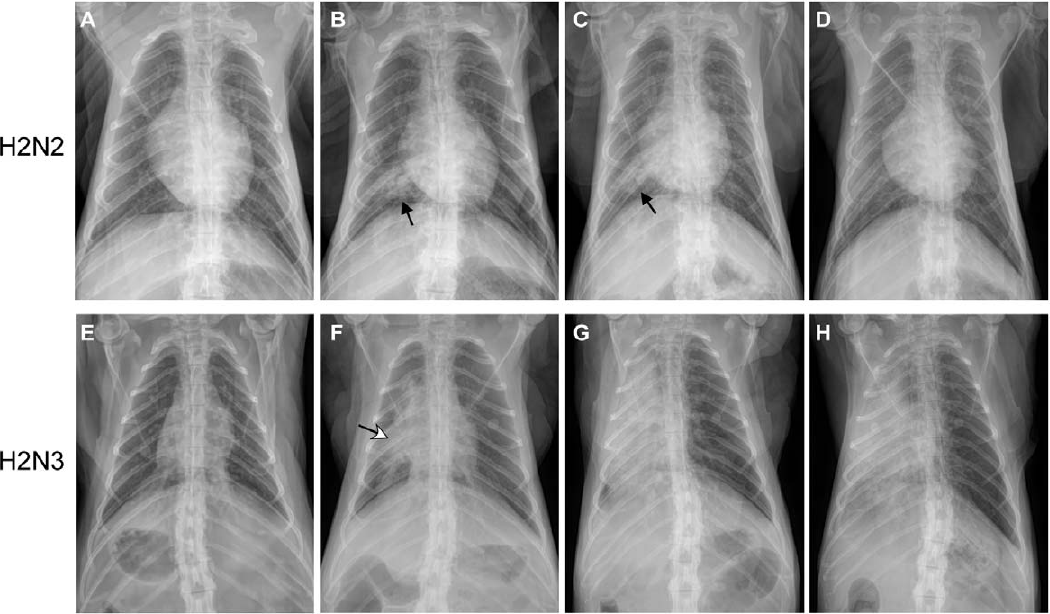
Figure 1. Radiographic imaging of disease progression. Time course ventrodorsal radiographs of representative macaques infected with either H2N2 or H2H3. Panels (A), (B), (C) and (D) represent time course radiographs from an individual animal at baseline, 3 dpi, 8 dpi, and 14 dpi infected with human H2N2 influenza virus. Focal interstitial radiographic changes (solid arrows) were noted on 3 dpi and 8 dpi but have resolved by 14 dpi. Panels (E), (F), (G) and (H) represent time course radiographs from an individual animal at baseline, 3 dpi, 8 dpi, and 14 dpi infected with swine H2N3 influenza virus. Focal interstitial changes with consolidation and partial effacement of the cardiac silhouette (open arrow) were noted. Radiographic changes are progressive on 8 dpi and 14 dpi with complete effacement of the cardiac silhouette and consolidation within the entire right hemi-thorax. Radiographic scoring was performed as previously published [21]. doi:10.1371/journal.pone.0039990.g001 PLoS ONE |